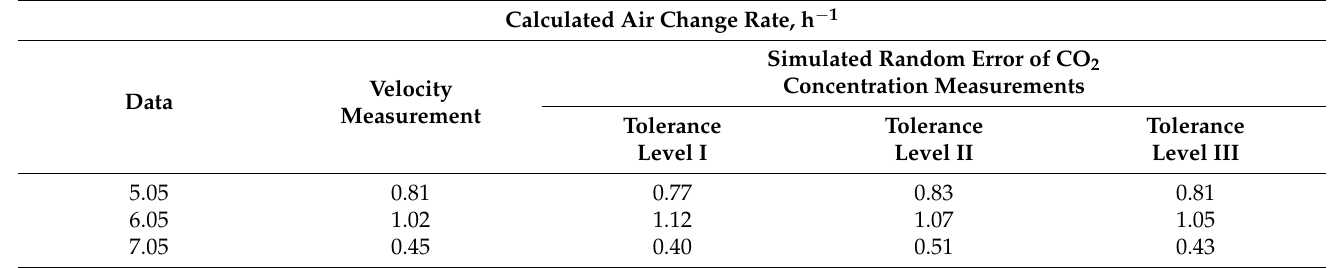
Table 3. Analysis of the random errors of measured CO 2 concentration on estimated air change rate.